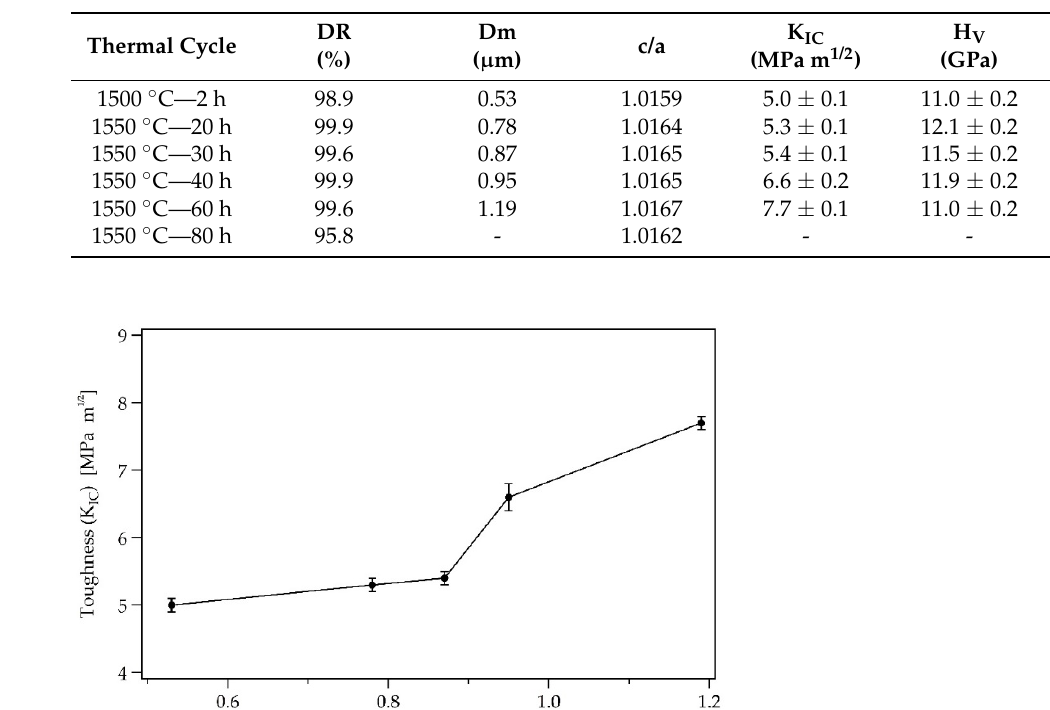
Table 4. Properties of zirconia-based (3Y-TZP) samples sintered with different thermal cycles. DR is the relative density, Dm the average grain size, c/a is the tetragonality, K IC the fracture toughness, and H V the microhardness.